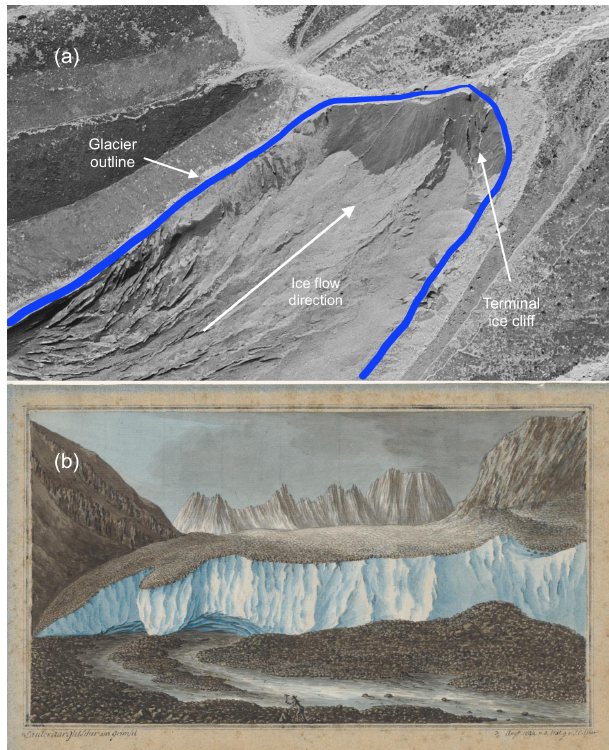
Figure A1. Examples of debris-covered glaciers with an ice cliff terminus: (a) satellite image of Tsijiore Nouve Glacier in 1988 (re- production with permission from Swisstopo, BA20059) and (b) a painting of the terminus of Unteraargletscher from 1794 (Escher von der Linth, 1794).